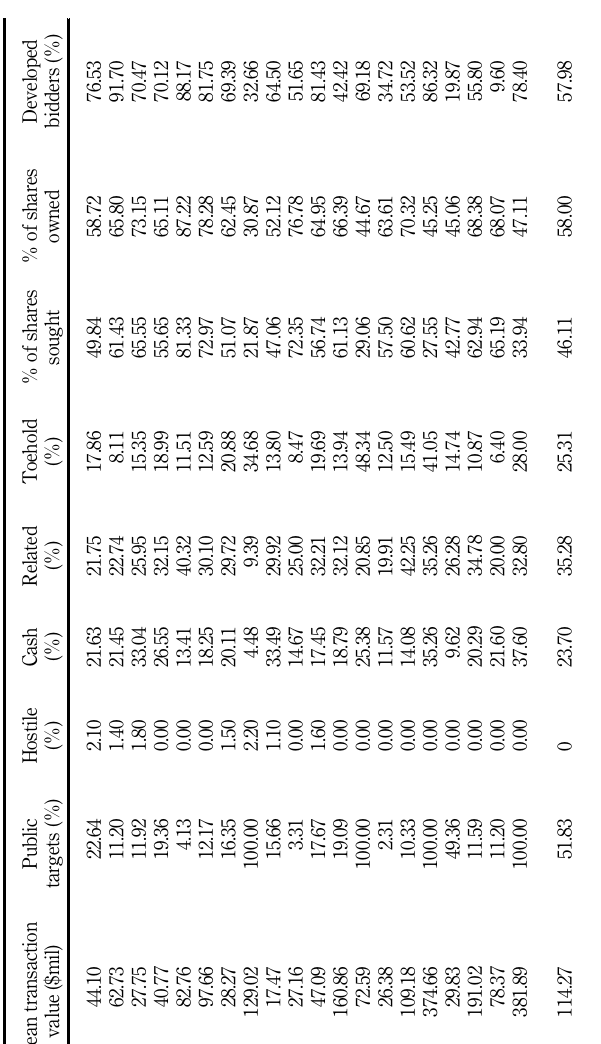
Table 1. Data on completed cross-border mergers and acquisitions